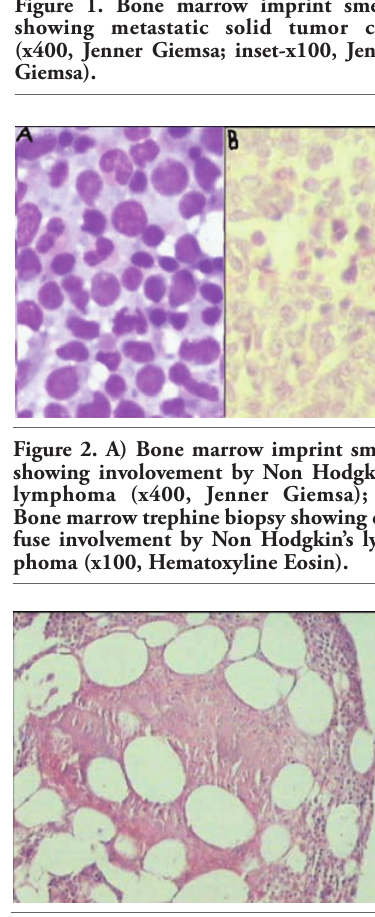
Table 3. Cases where findings on Bone marrow aspirate cytology, touch imprint cytology or trephine biopsy differed from final diagnosis. Diagnosis